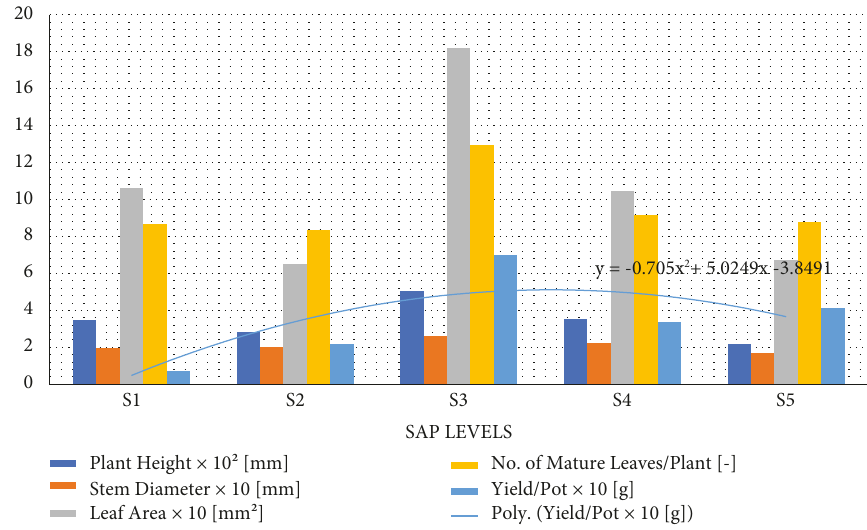
Figure 2: Effect of SAP on African nightshade growth and yield. Table 6: ANOVA for dependent variables and their interaction on cowpea plant yield at 95% confidence level. P -values at 95% confidence level Source of variation